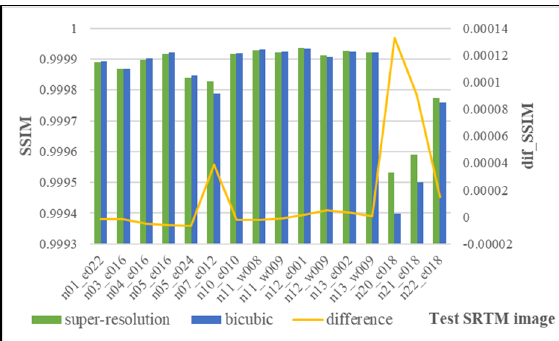
Figure 5 Quantitative evaluation on the SRTM test